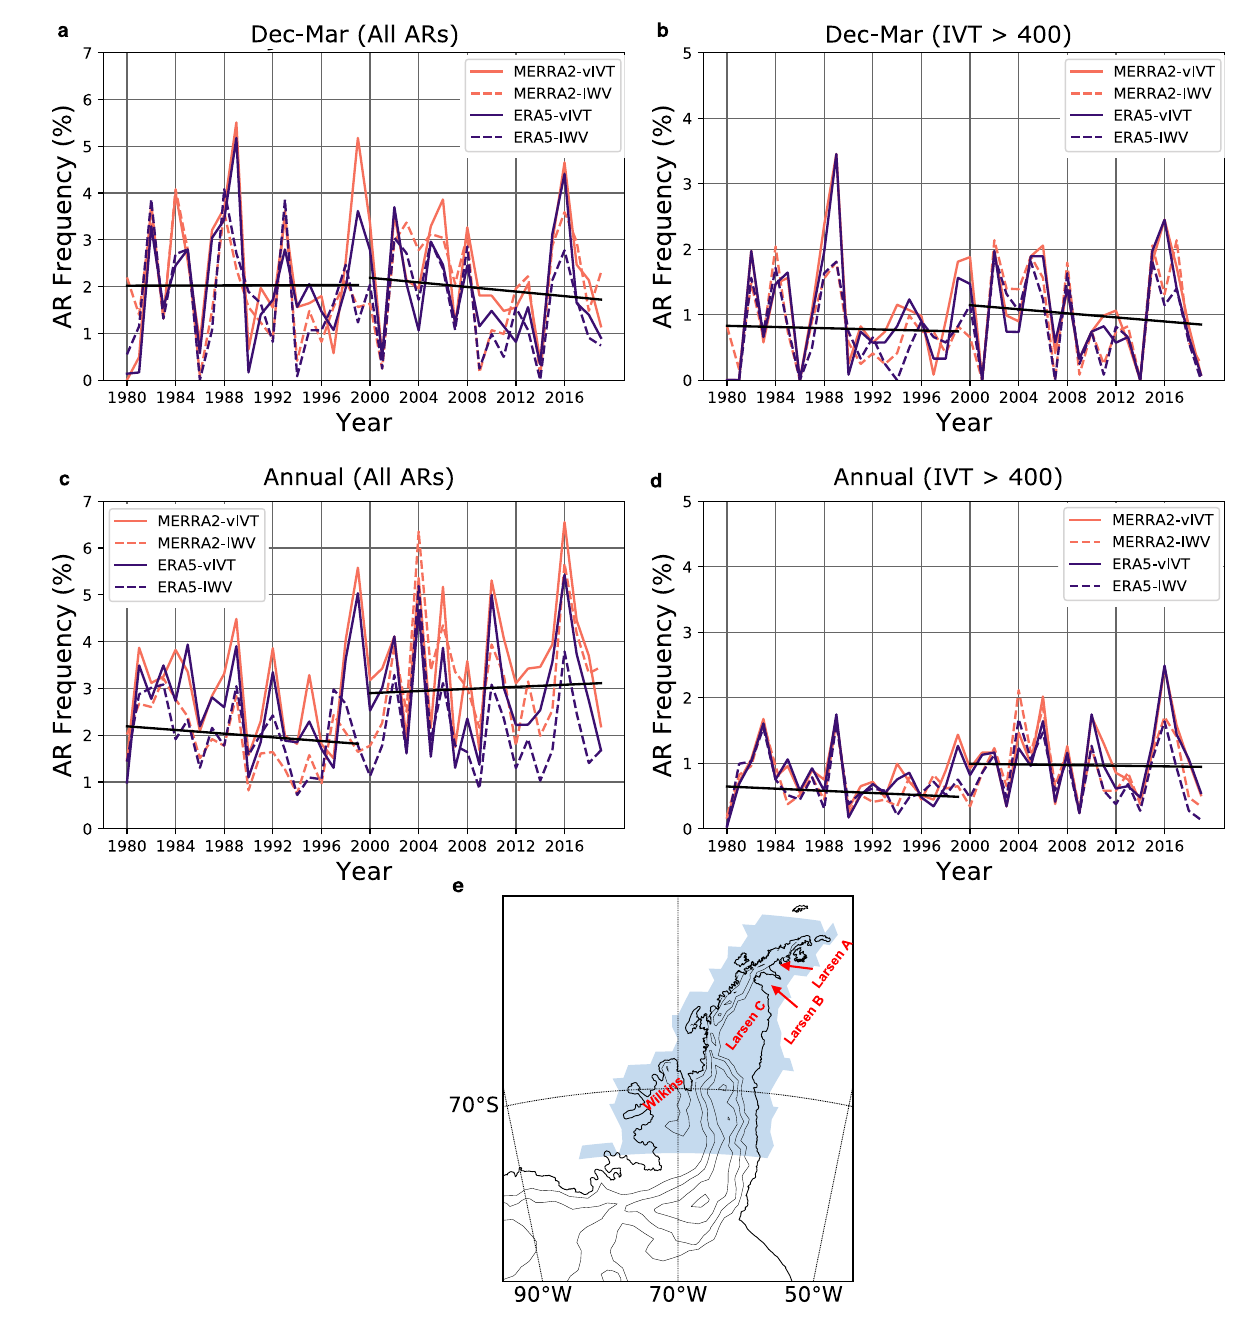
Fig. 1 Annual AR frequency and trends. Frequency of AR landfalls on the Antarctica Peninsula for a , b December – March and c , d yearly according to the vIVT and IWV AR detections schemes when applied to MERRA-2 and ERA-5 reanalysis. b , d represent the AR frequency when all AR landfalls with a maximum IVT below 400 kg m − 1 s − 1 are removed from the record. The year in a and b refers to the austral summer of December, January, February, March (i.e., the austral summer of 1988-1989 is referenced as 1989 in the plots). An AR landfall is counted if an AR shape touches the region highlighted in e which also shows the locations of the Larsen A and B embayments, Larsen C ice shelf, and Wilkins ice